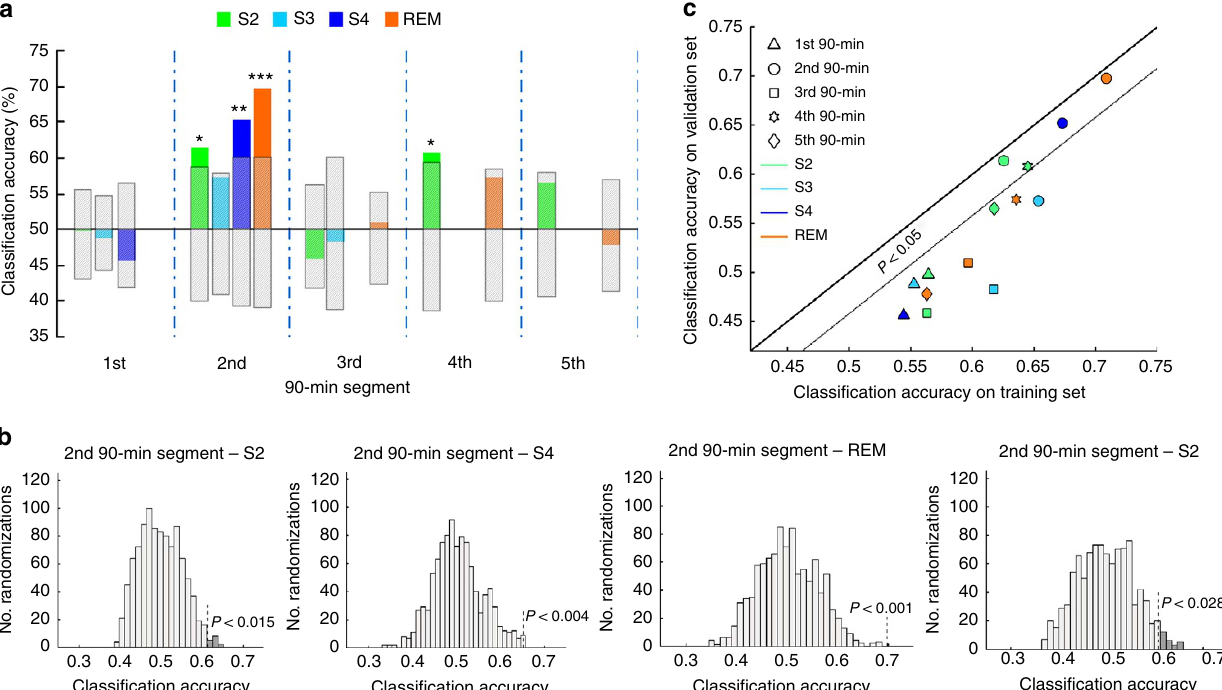
Figure 2 | Classification results. ( a ) The content of a previous learning experience can be determined from sleep EEG during the second and fourth 90- min segment of the night. At these times, classification accuracy for all sleep stages is significant or approaches significance. The hatched area shows the 95% confidence interval. Classification accuracies for S4 sleep as well as REM sleep in the second sleep segment remain significant after Bonferroni–Holm correction considering all tests (S4: P ¼ 0.048, REM: P ¼ 0.014). ( b ) Significance was assessed using permutation tests to ensure that classification rates are higher than can be expected from data sets with random labelling of the data, that is, not containing any information. To estimate the displayed null- distribution from which exact significance levels of classification results can be determined, the MVPC analysis was repeated 1,001 times on the actual data with randomly shuffled condition labels. Dark grey areas show those randomizations during which classification accuracy on randomly labelled data exceeded accuracy obtained on correctly labelled data. ( c ) If classification accuracies are similar between the training and validation sets, generalizable information could be extracted and the classifier was not overfitted on the training data set. This was the case for all analyses that were significant, that is, for data from the second (circles) and fourth (stars) 90-min segments of the night. Here patterns detected in one set of subjects during classifier training can be generalized to data from a new set of subjects. Data from the first (triangles) and third (squares) 90-min segments show low training accuracy and low accuracy on validation data, indicating that the classifier could not extract information about previous learning content from these periods of the